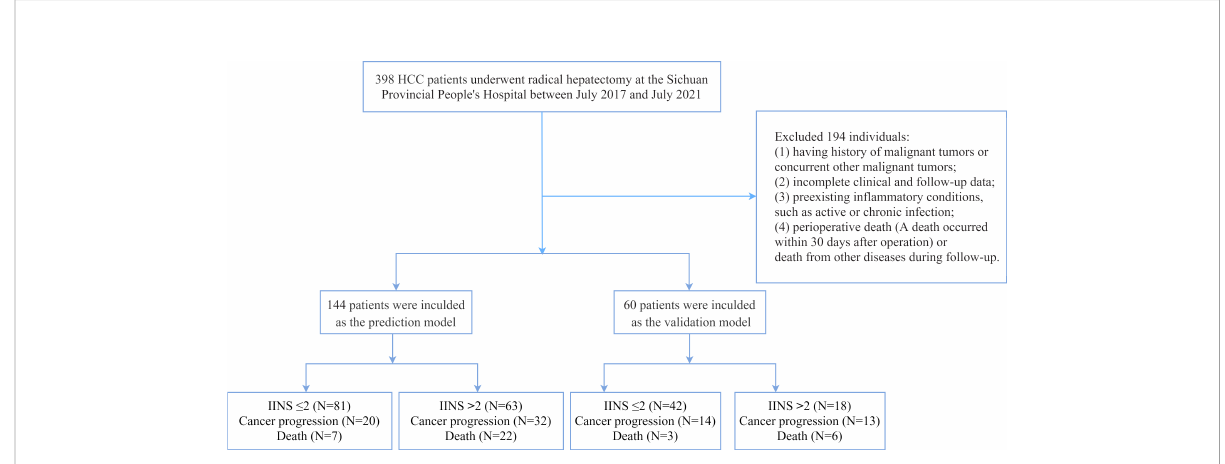
FIGURE 1 The fl owchart of patients enrolled in this study. HCC, hepatocellular carcinoma; IINS, in fl ammation-immunity-nutrition